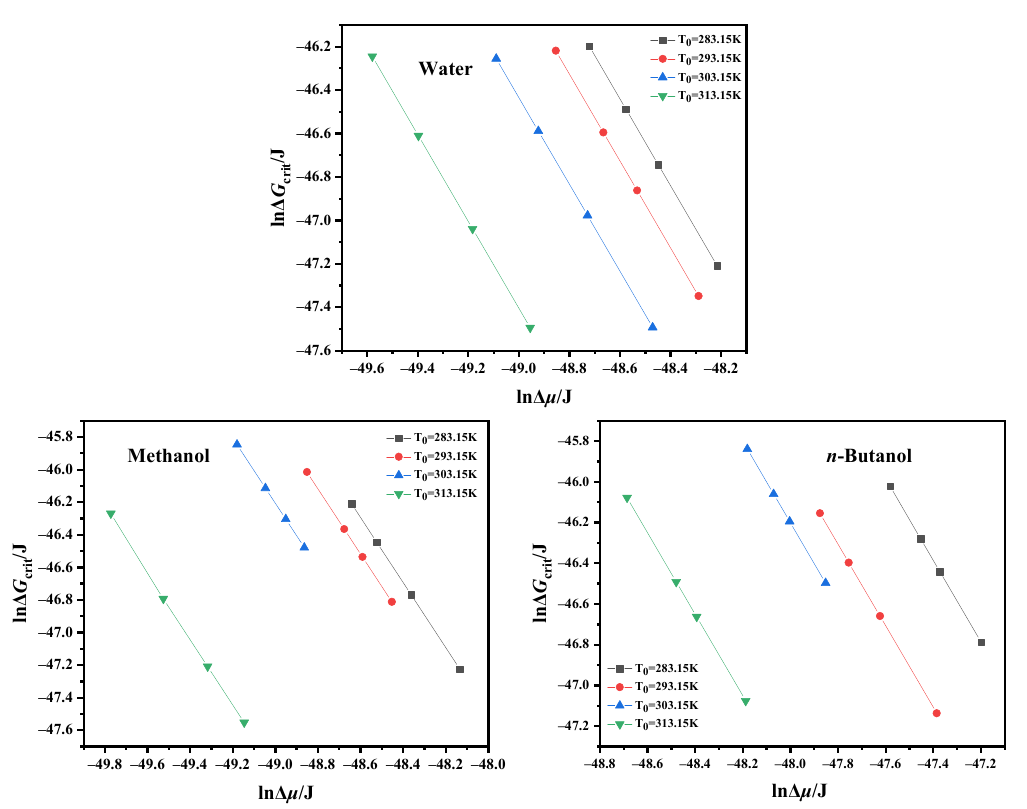
Figure 11. Relationships between driving force and nucleation Gibbs free energy.